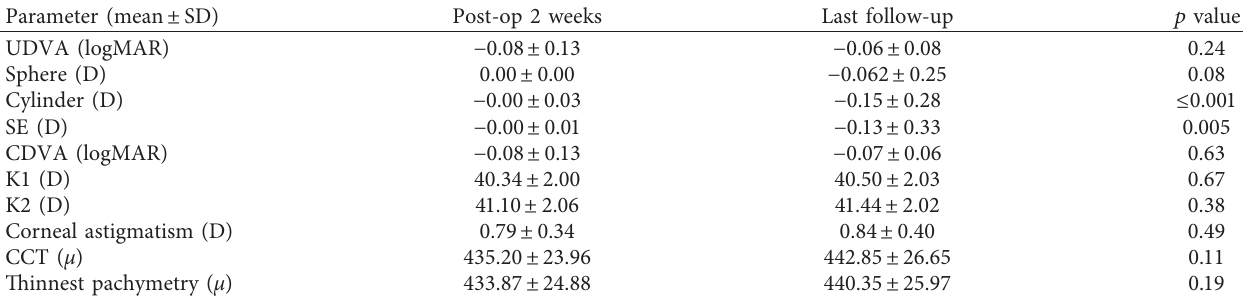
Table 4: Visual and refractive parameters 2 weeks post-op versus mean follow-up in the SMILE XTRA group. Parameter (mean ± SD)